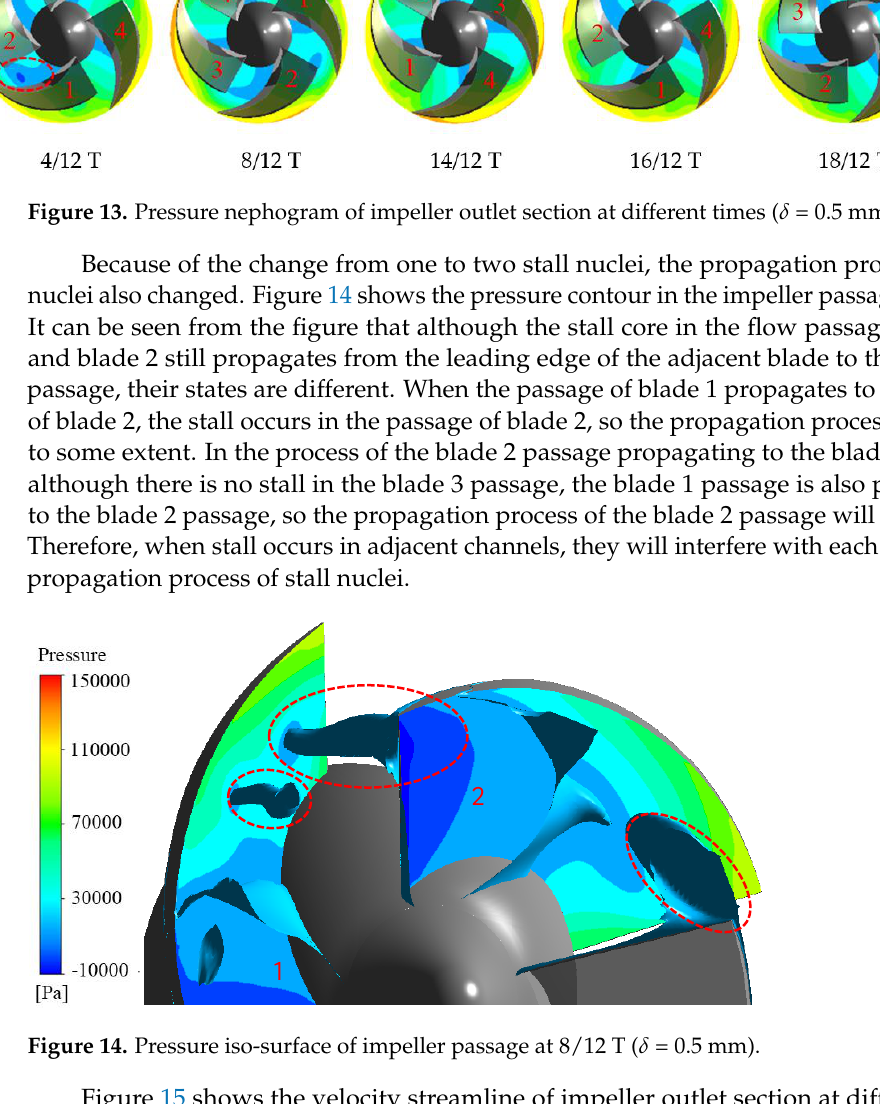
Figure 12. Velocity streamline diagram of impeller outlet section at different time ( δ = 0.5 mm).